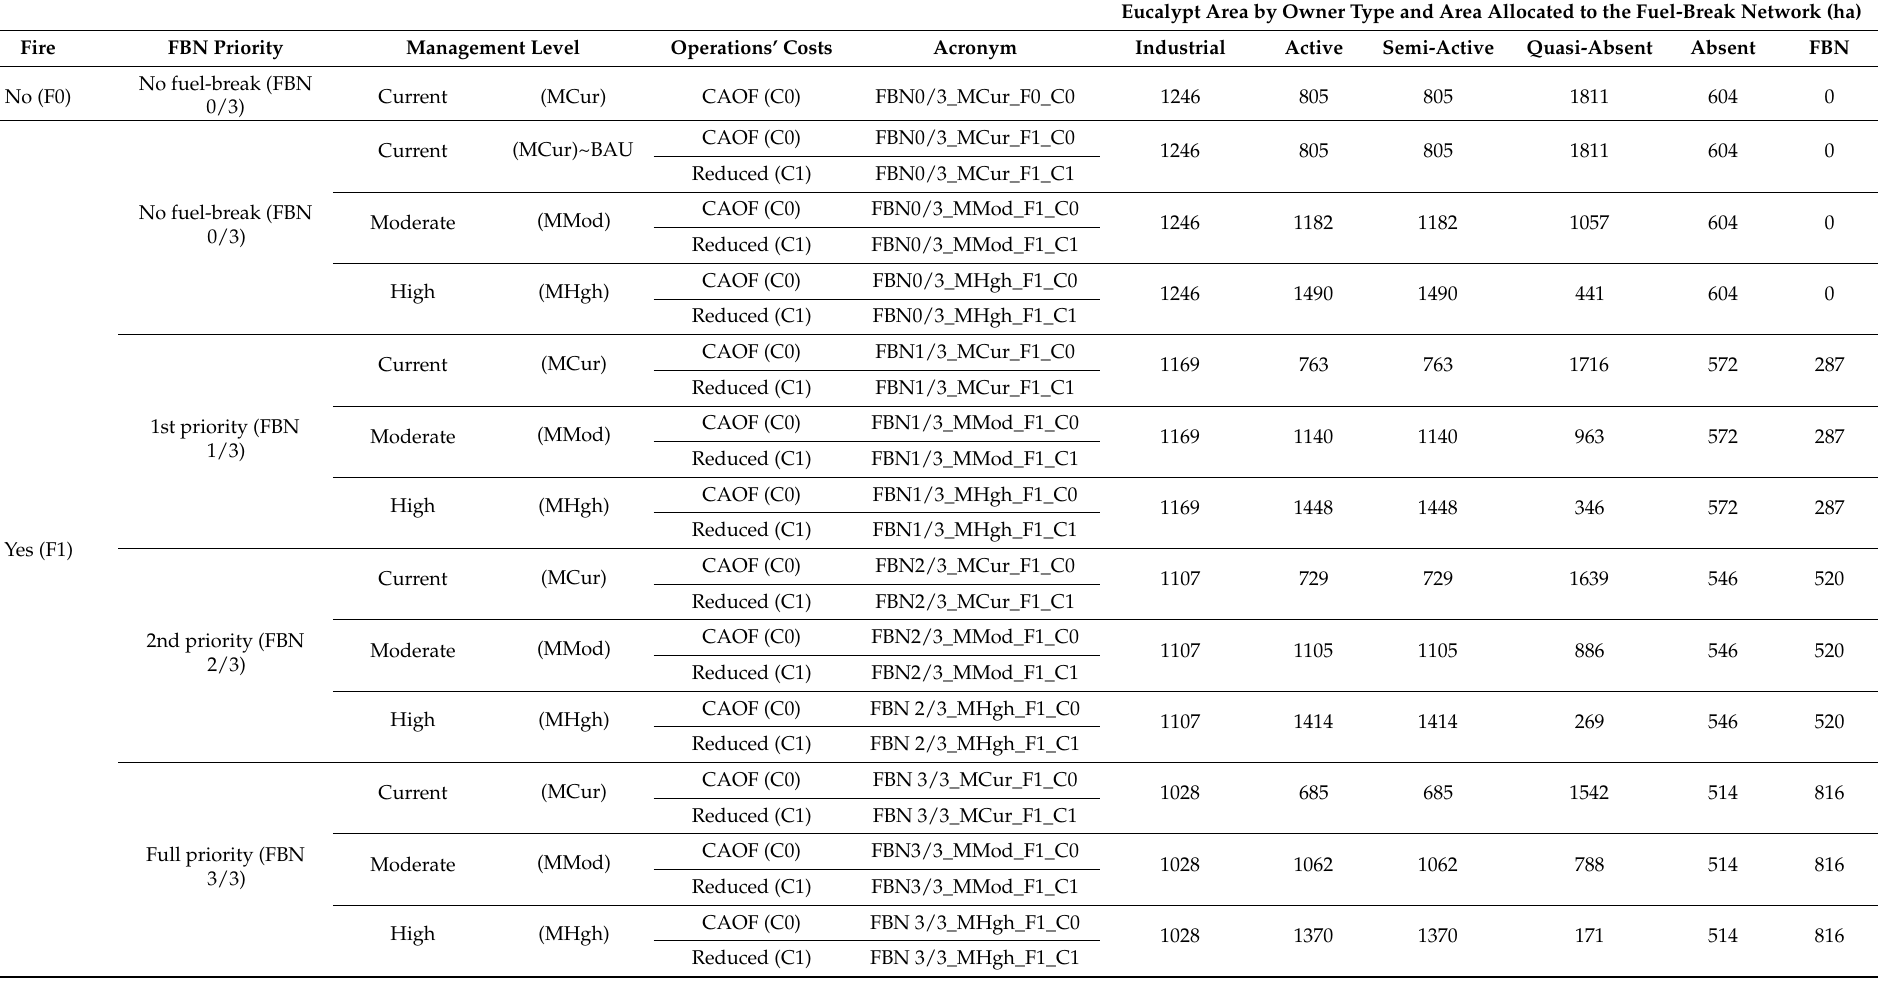
Table A1. Description of the scenarios in terms of areas assigned by owner type/FMA and area allocated to the fuel break network. Eucalypt Area by Owner Type and Area Allocated to the Fuel-Break Network